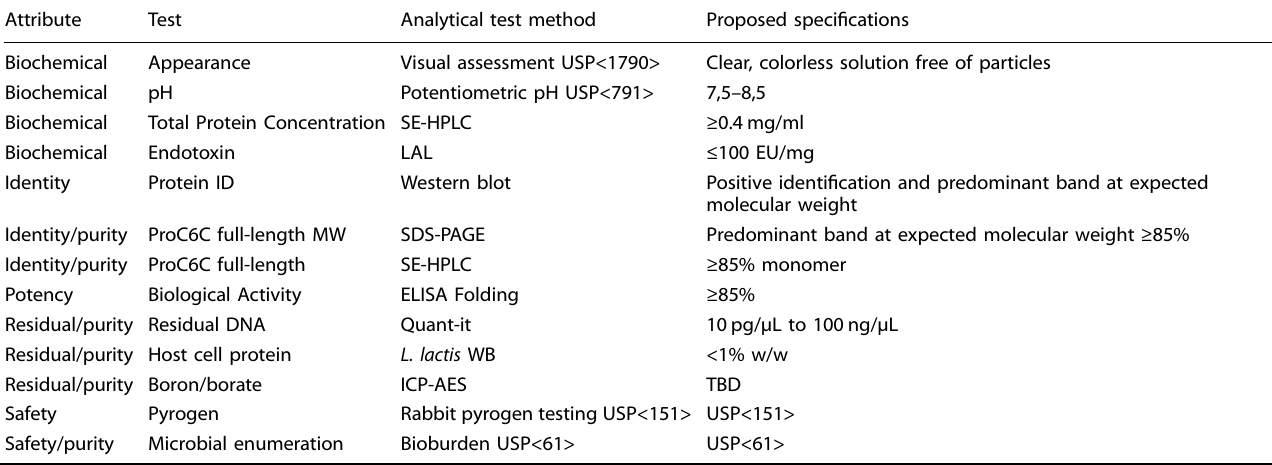
Table 3. ProC6C cGMP proposed release